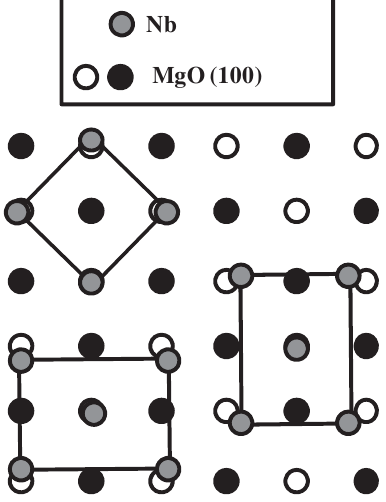
FIG. 1. Overlays of relaxed Nb lattices on an MgO(100)